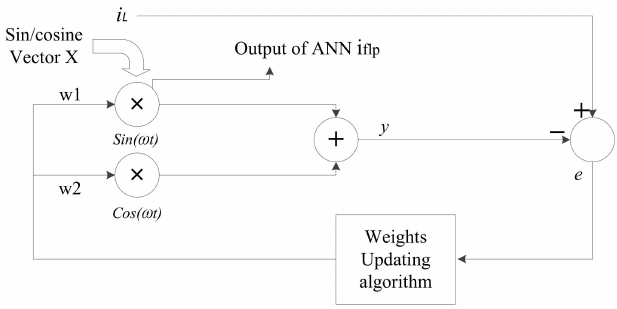
Figure 3. ADALINE neural network